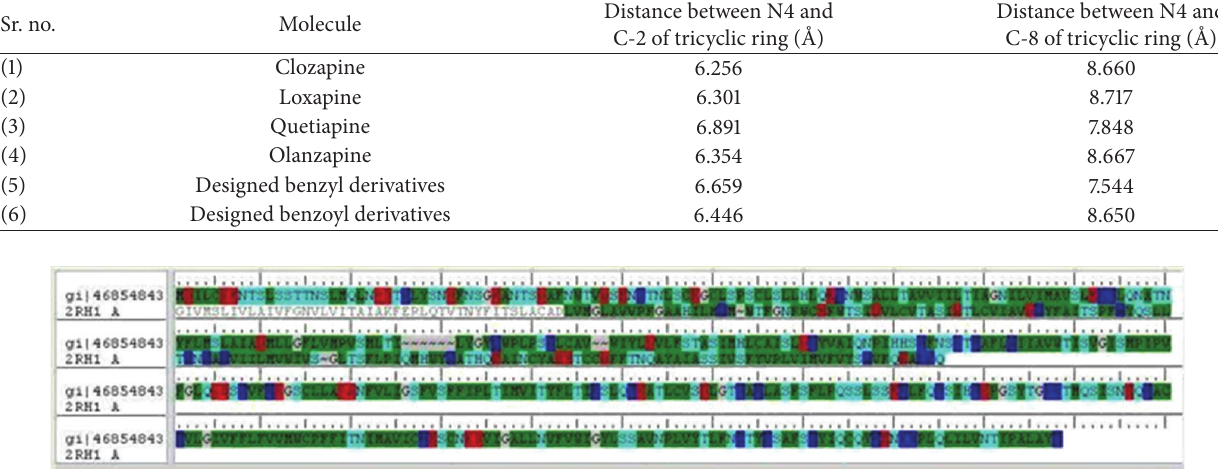
Figure 5: Alignment of FASTA sequence of 5-HT